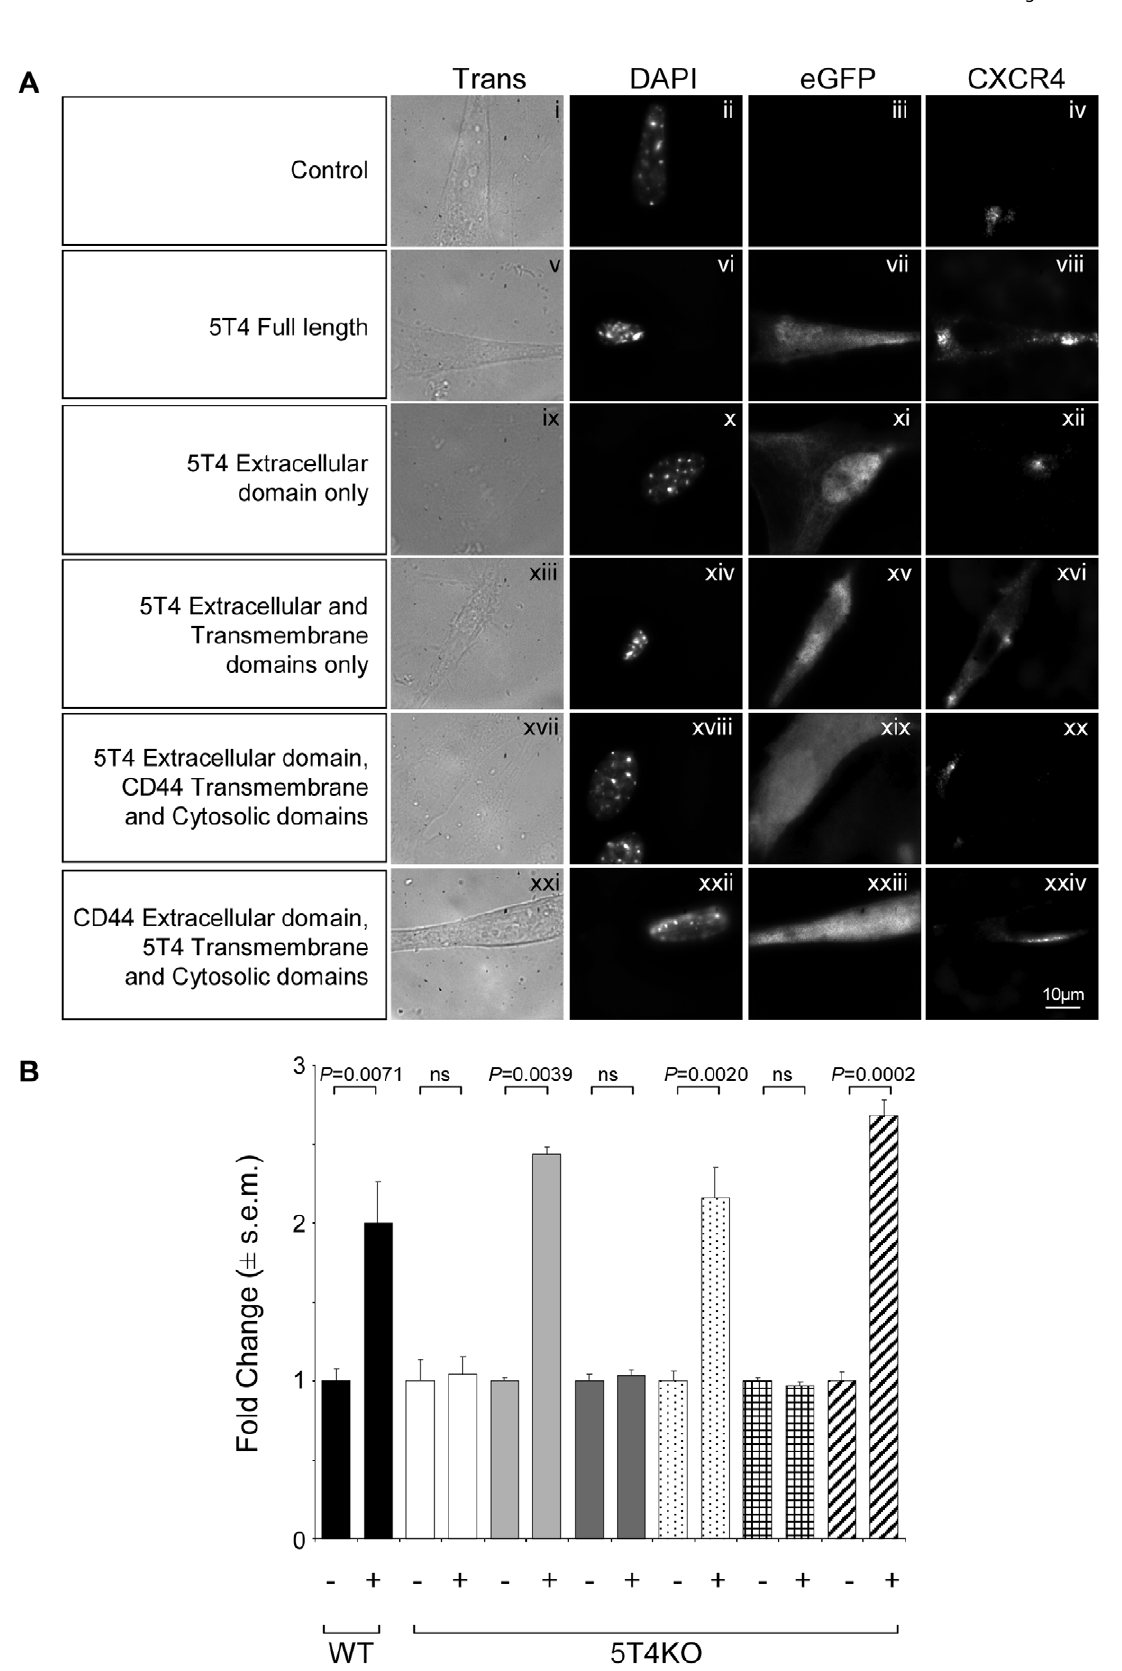
5T4 Regulates CXCR4 Chemotaxis